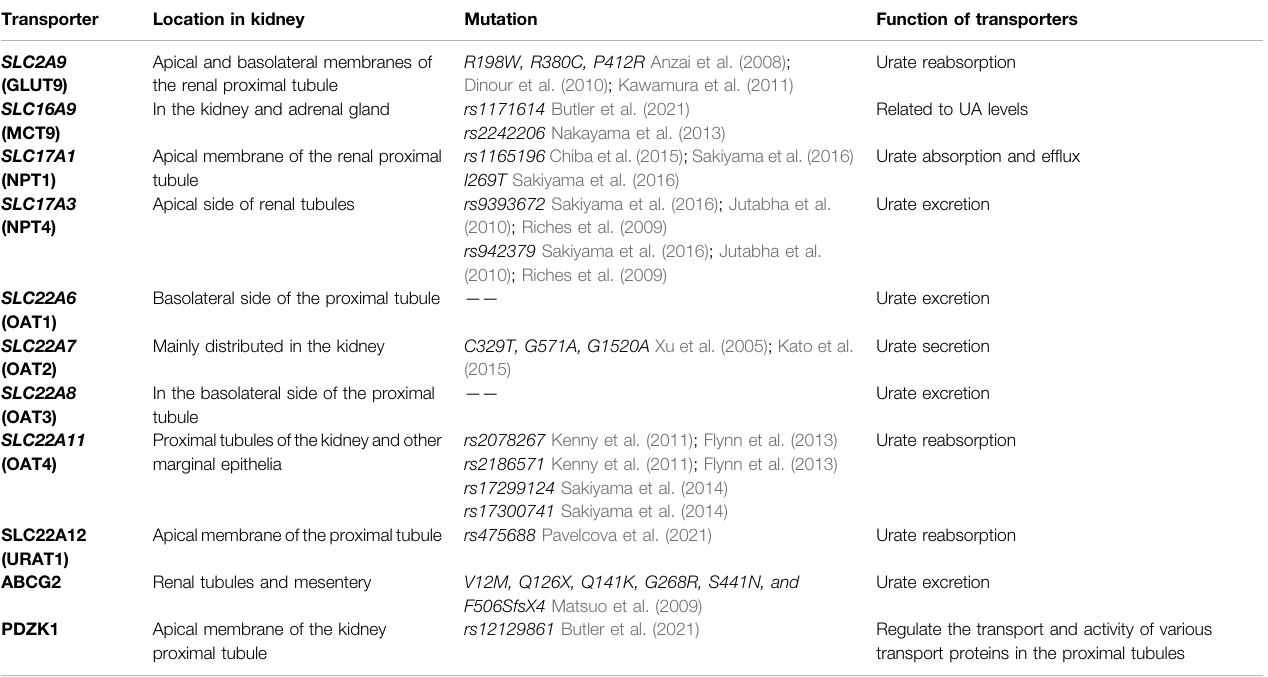
TABLE 1 | Characteristics of Urate